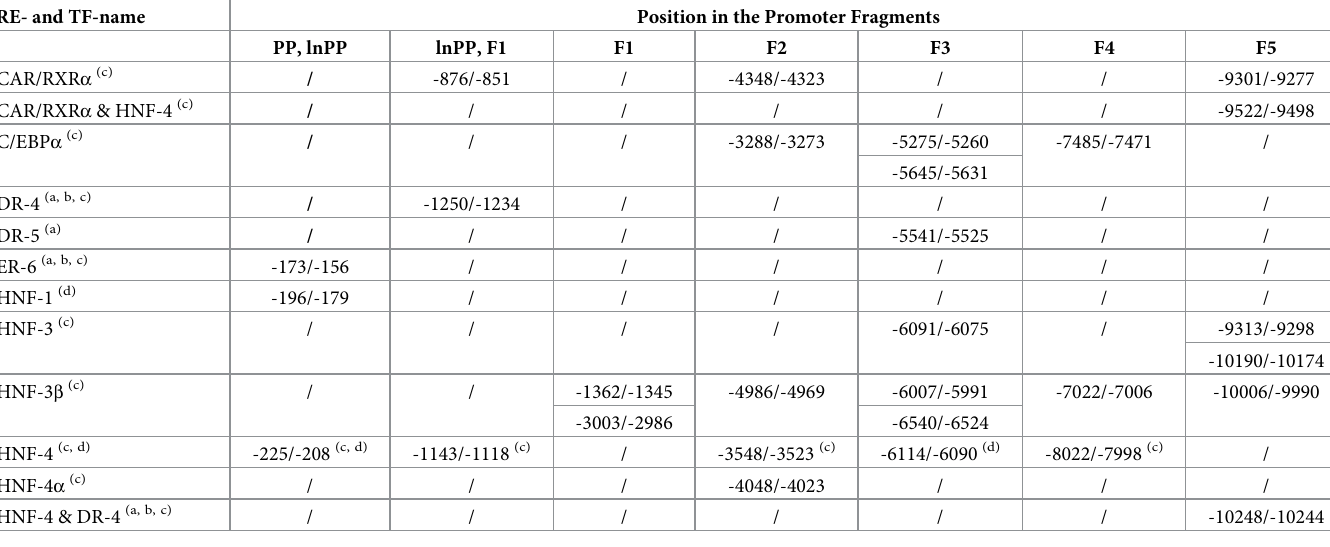
Table 1. Results from in silico screening of bovine CYP3A28 gene promoter. RE- and